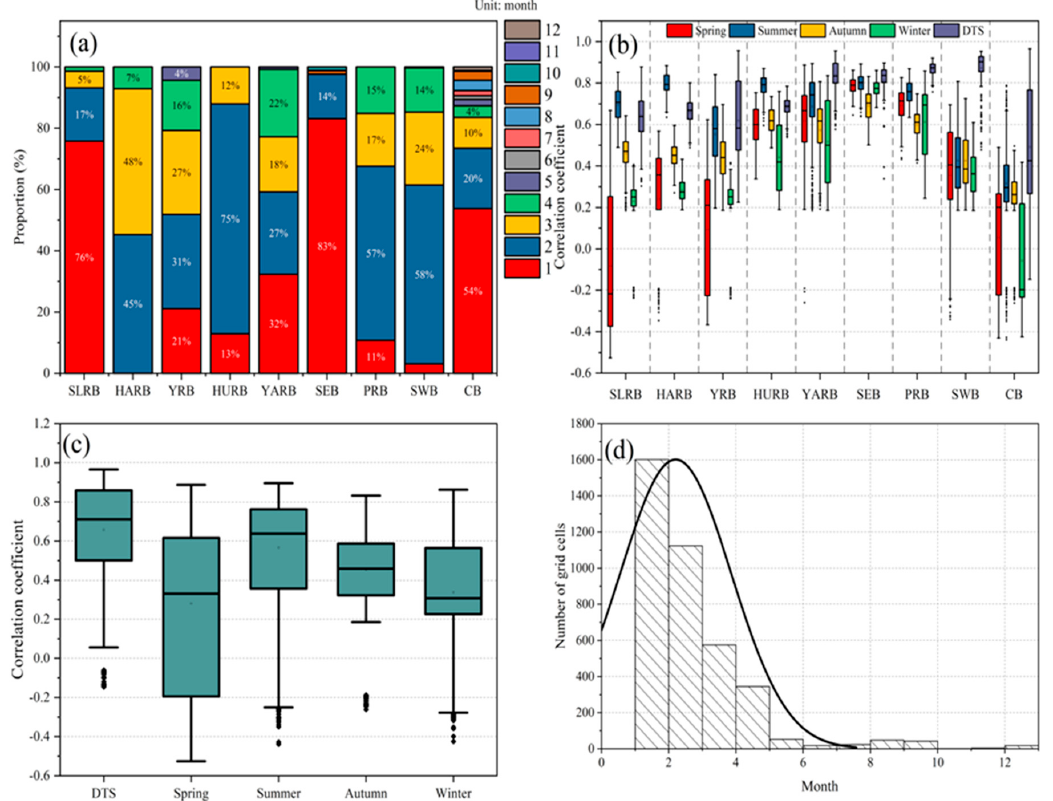
Figure 3. Box diagram showing the response relationship in different seasons and timescales ( a ) and propagation times ( b ) between the SPI and SRI for different river basins. Box diagram showing the response relationship between in different season in China ( c ) drought response time in DTS in China ( d ). DTS represents different timescales.